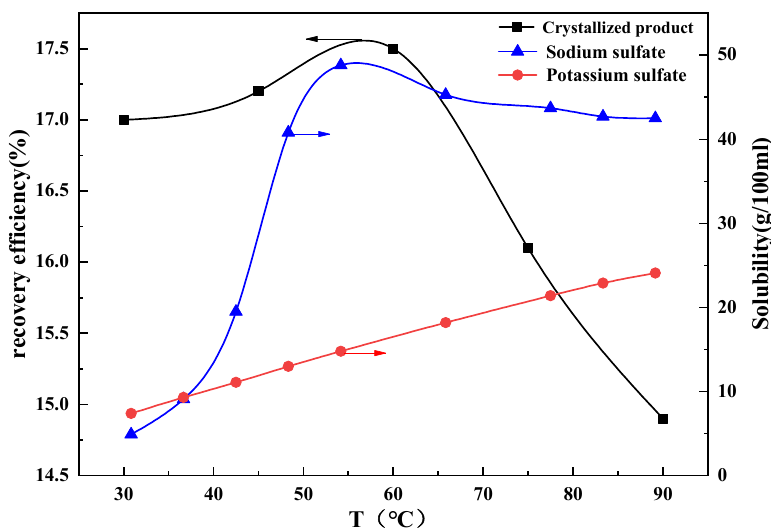
Figure 9. E ff ect of temperature on recovery e ffi ciency of the crystallized product (leaching time 30 min, Figure 9. Effect of temperature on recovery efficiency of the crystallized product (leaching time 30 Liquid to solid ratio 20) and Solubility of K 2 SO 4 and Na 2 SO 4 . min, Liquid to solid ratio 20) and Solubility of K 2 SO 4 and Na 2 SO 4 .